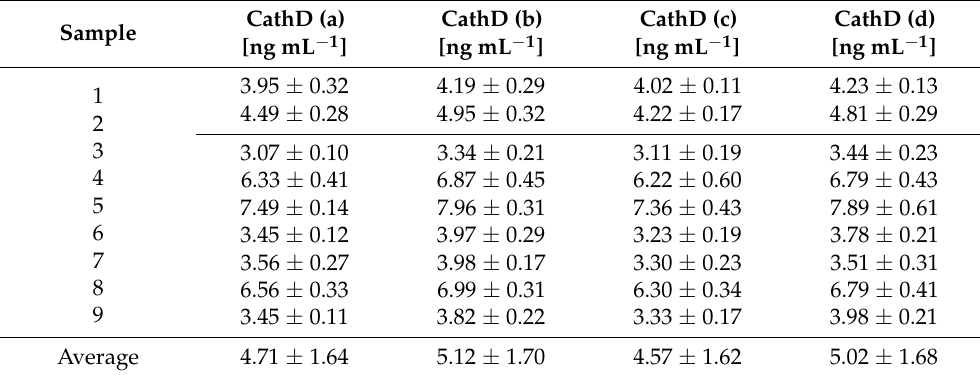
Table 8. Concentration of Cath D in serum of patients suffering from glioblastoma as determined